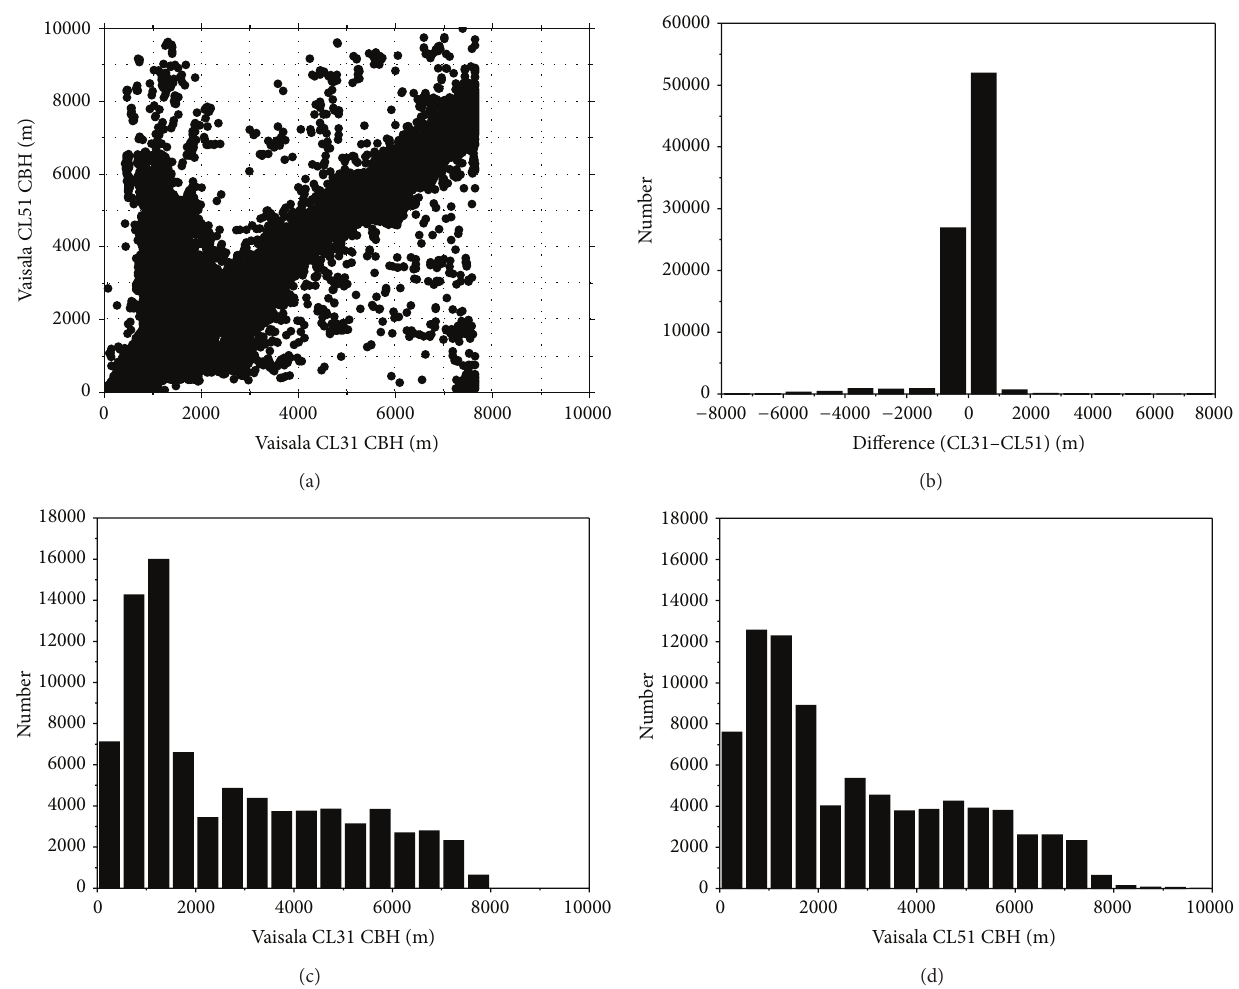
Figure 3: Cloud base height differences between ceilometers CL31 and CL51 during the period November 1, 2011, and June 12, 2012, at the CMA Beijing Observatory